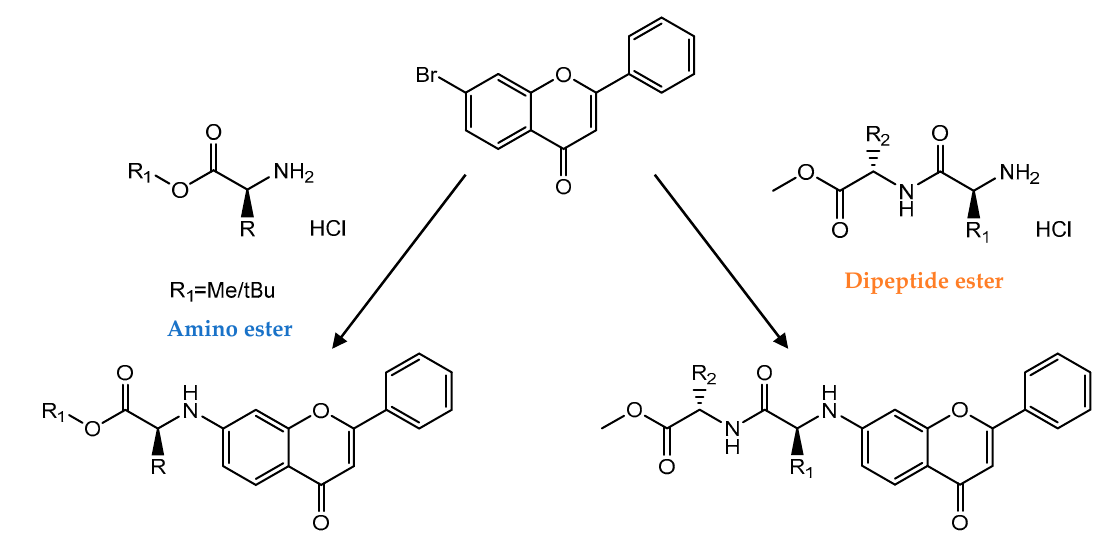
Figure 15. General scheme for synthesis of flavone amino acid derivatives through the Buchwald-Hartwig reaction.